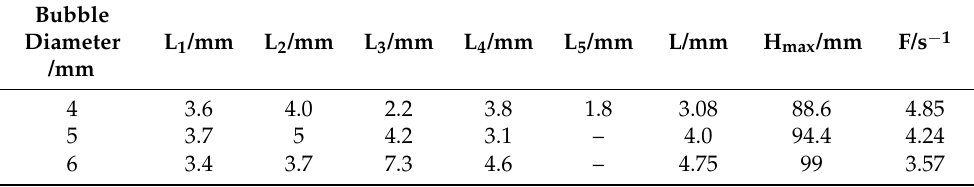
Figure 8. Graphs of the average rising velocity of bubbles under different S*.